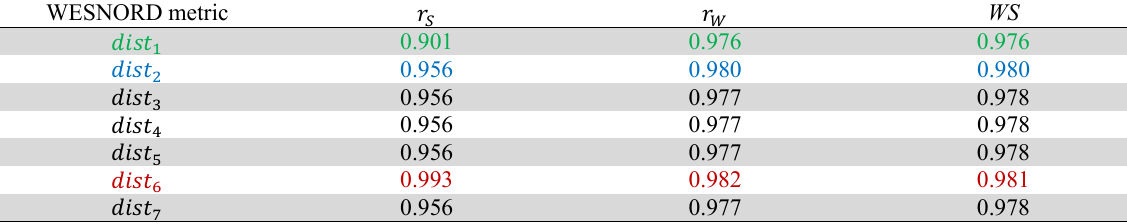
Correlation coefficients between the rankings provided by the RPs and the reference ranking WESNORD